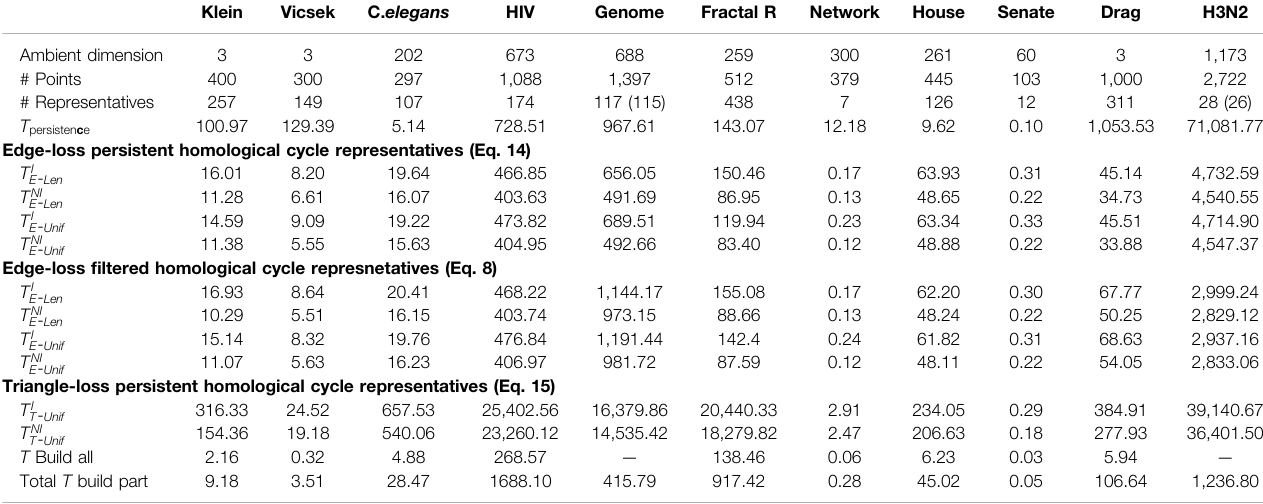
TABLE 1 | Summary of the experimental results of the data sets from Otter et al. (2017) as described in Section 5.1 . The rows include the ambient dimension, number of points, the number of cycle representatives in H 1 , and the time (measured in seconds) it took to compute persistent homology for each data set. We also include the computation time taken to optimize the set ofcycle representatives under sixdifferent optimization problems, and computation time of twodifferent implementation choices for the triangle-loss optimal cycles: building the full z 2 boundary matrix once and extracting the part needed, or constructing part of the z 2 boundary matrix for each cycle representative. In this table, T stands for computation time measured in seconds with subscripts indicating the type of the optimal cycle and superscripts indicating whethertheprogramwassolvedusinglinearprogramming(NI)orintegerprogramming(I).Thetimetakentoconstructtheinputtotheoptimizationproblemisincludedin the optimization time for edge-loss minimal cycle representatives, but is excluded and separately listed in the last two rows for the triangle-loss minimal cycle representatives. For triangle-loss cycles, we were able to compute 115 out of the 117 cycle representatives for the Genome data set and 52 out of 57 cycle representatives for the H3N2 data set due to memory constraints. The numbers in the parenthesis represent the other optimization statistics corresponding to the triangle-lossoptimalcycleswewereactuallyabletocompute.Thelasttworowscomparetwowaysofbuildingtheinput